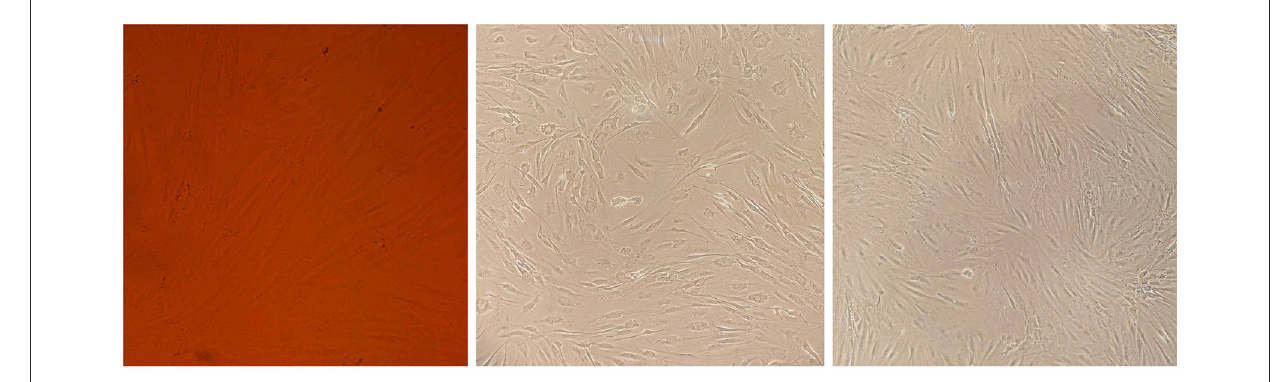
FIGURE3 Cell morphology assay of MSCs derived from the patient’s bone marrow. The spindle-shaped MSCs are visible at several growth rates.